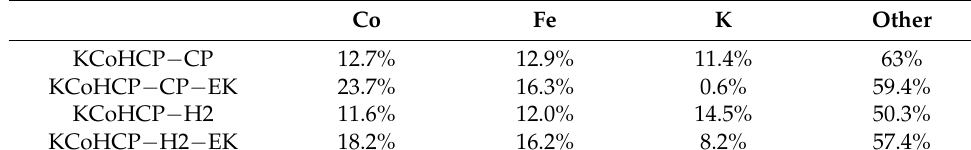
Table 1. Results of ICP − OES measurements of three element (Co, Fe, K) weight percentage in KCoHCP − CP, KCoHCP − CP − EK, KCoHCP − H2, and KCoHCP − H2 − EK. Co Fe K